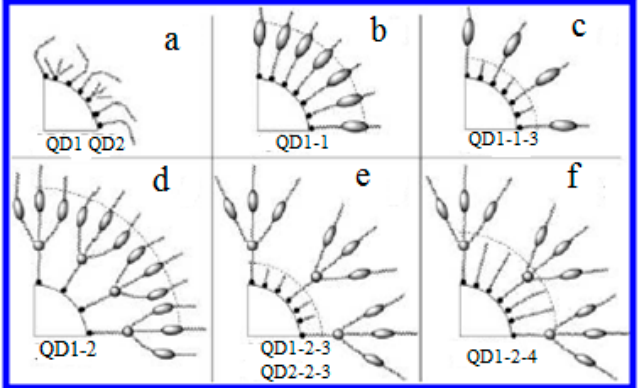
Figure 6. Schematic representation of the quantum dots (QDs) grafted with the surfactants; ( a ) native surfactant and ( b – f ) the new surfactants. The dotted lines indicate a possible depth of penetration of 4-cyano-4'-n-pentylbiphenyl (5CB) molecules into the QDs shell [37].